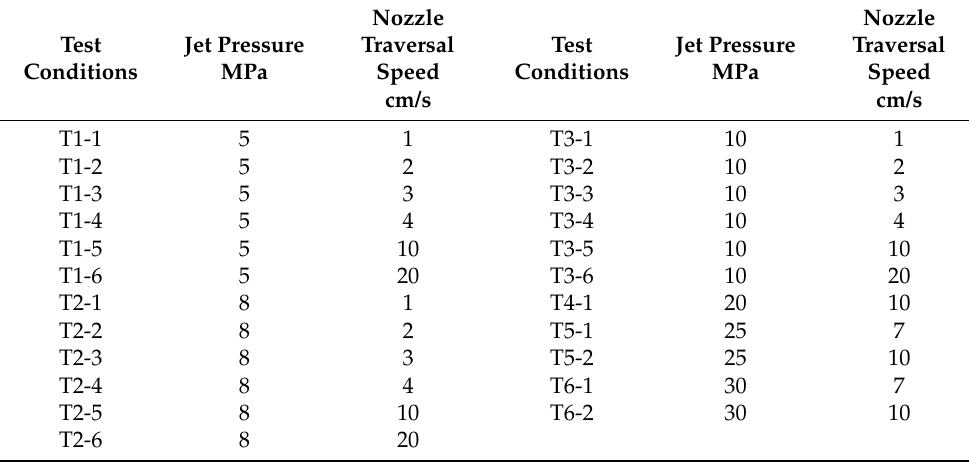
Table 3. Test scheme of water jet breaking soil.